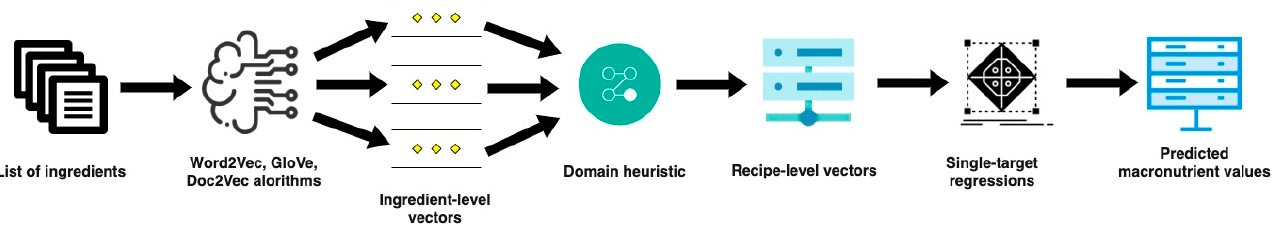
Figure 1. Flowchart of the presented approach.